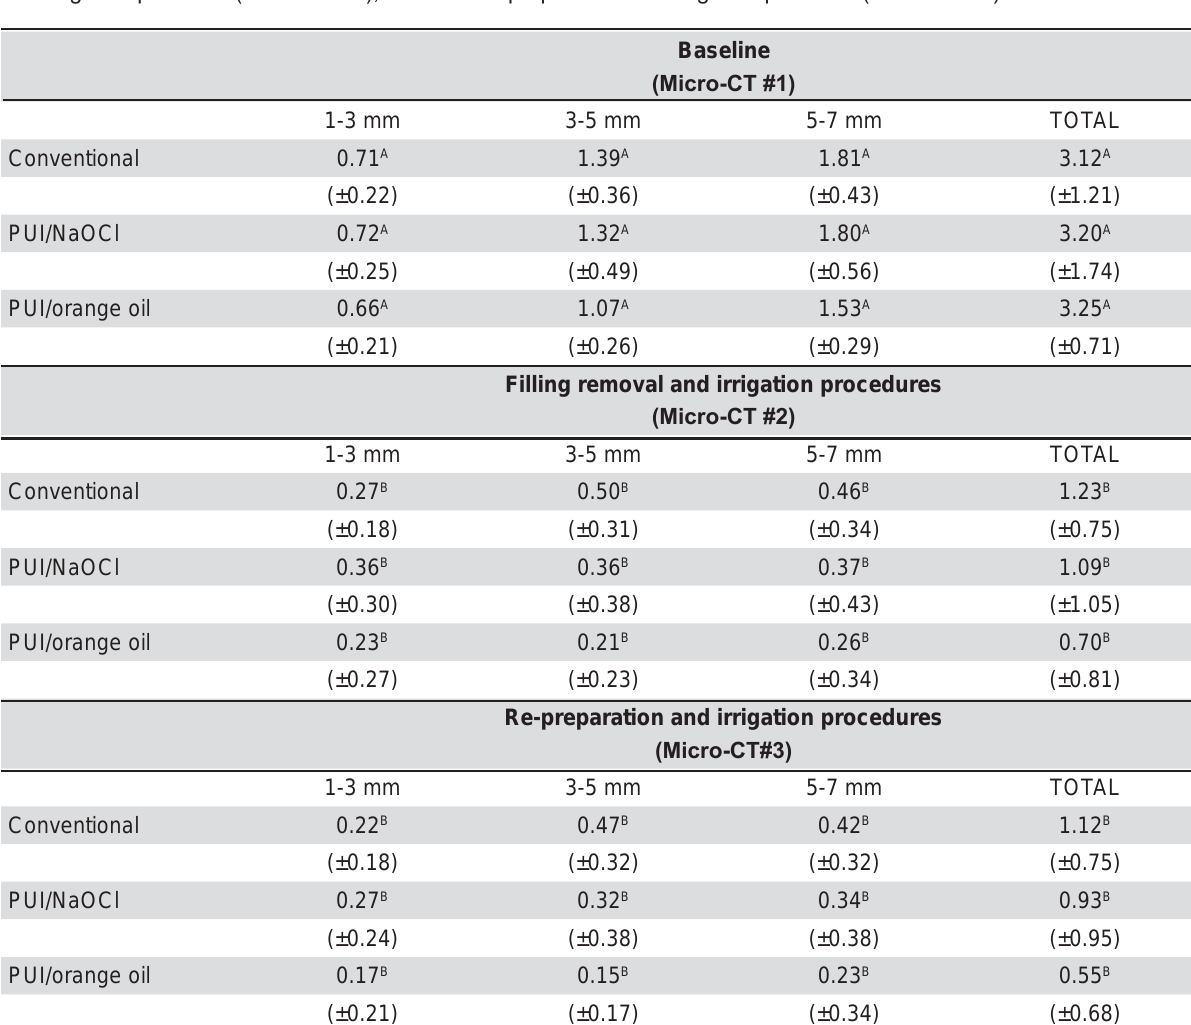
Table 1- Mean and standard deviation of the volume (mm 3